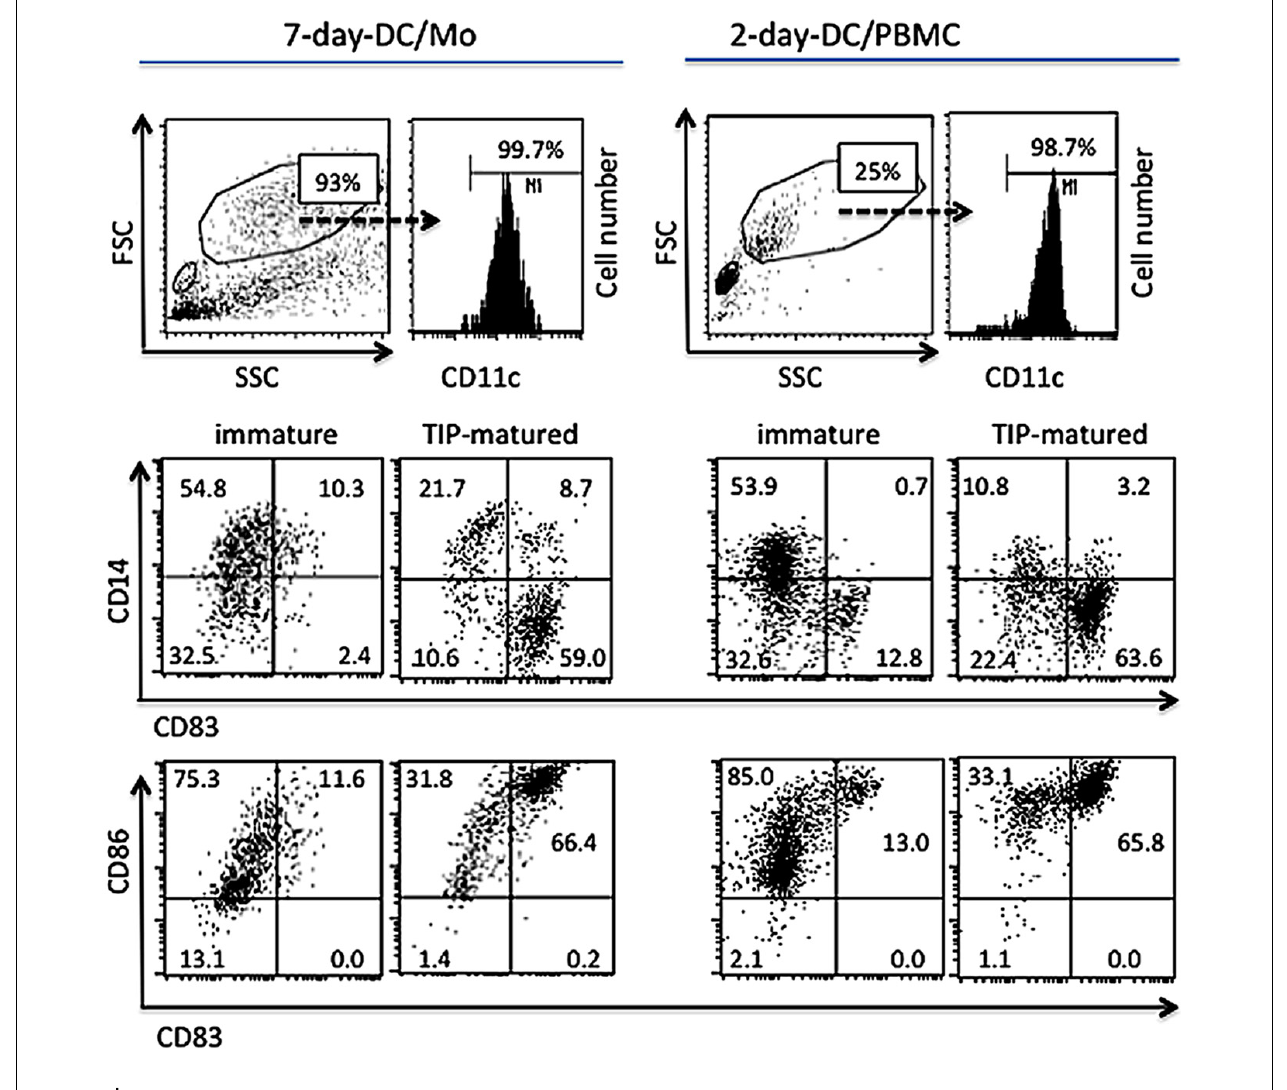
markers by a flow cytometry. Cells were stained with antibodies to CD11c, CD14, CD83 and CD86, and analyzed on a subpopulation gated for FSC high , SSC high and CD11c + . The percentages of the positive cells in the gated population were shown in the dot plots. Data shown are representative of three independent experiments using blood from three different